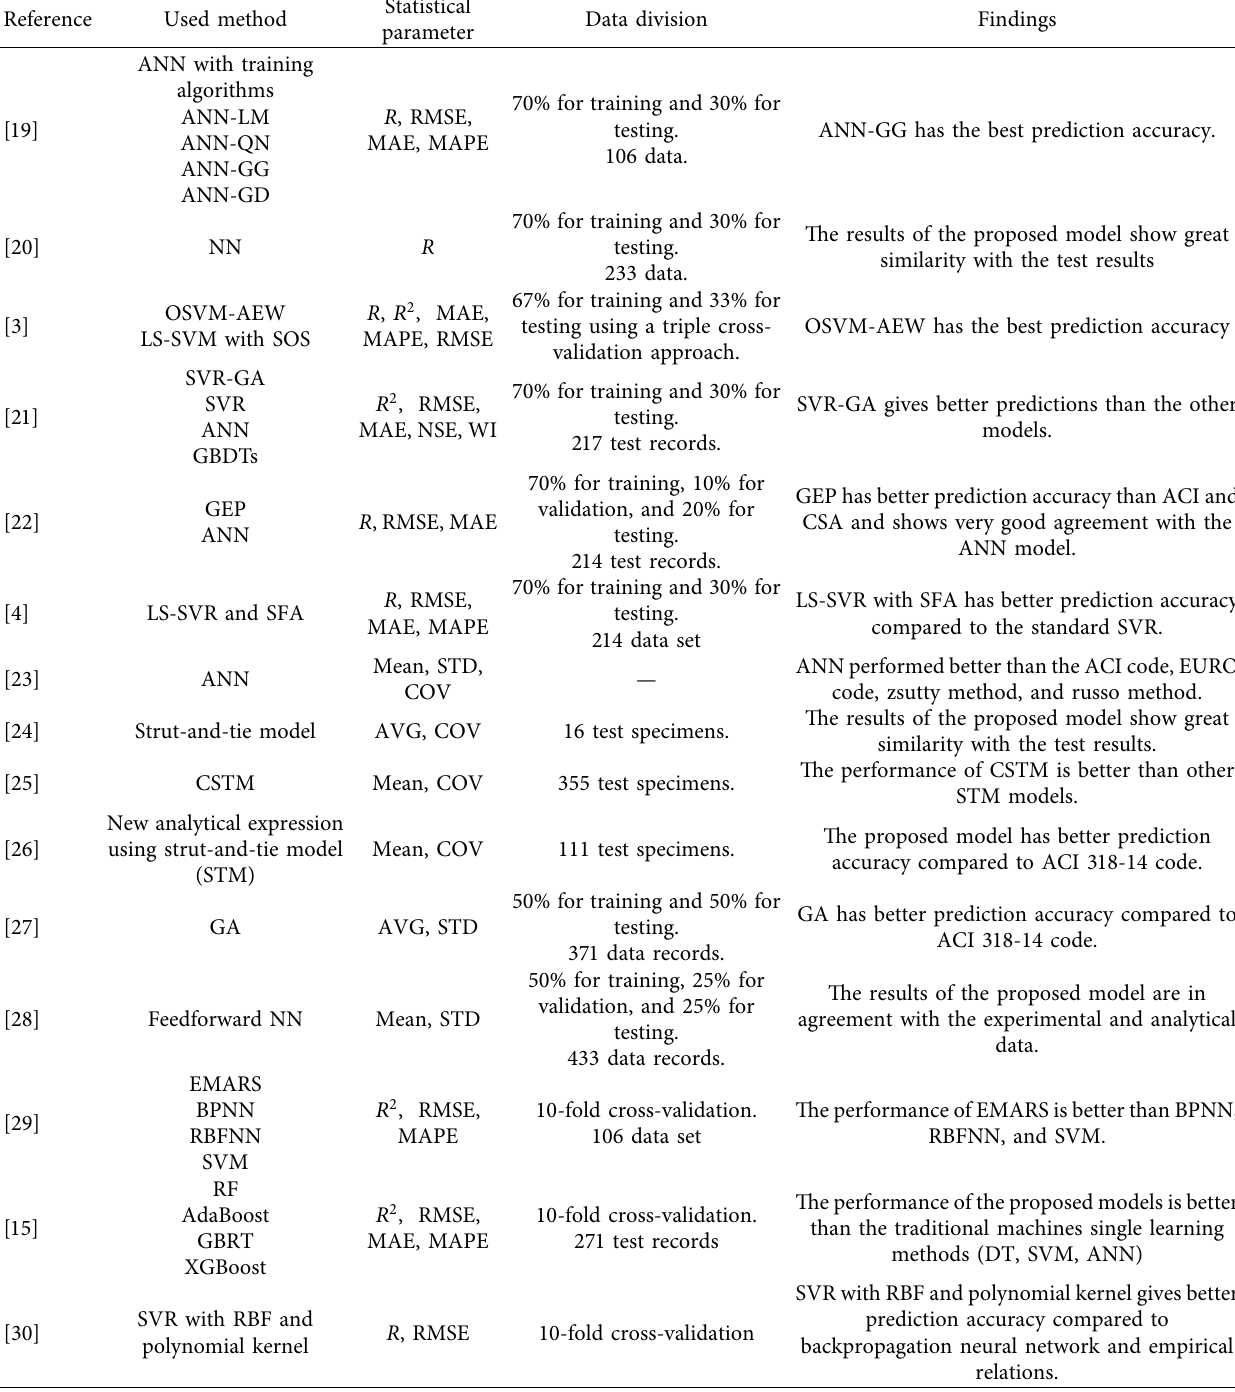
Table 1: Examples of different SC models and empirical equations in modelling the shear strength.